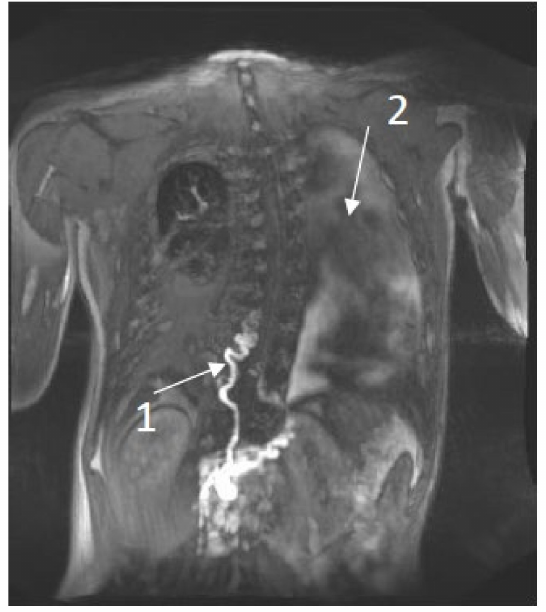
Figure 1. DCMRL results of a 20-year-old male with NS. 1. Abnormal tortuous thoracic duct and partial aplasia. 2. Left-sided pleural